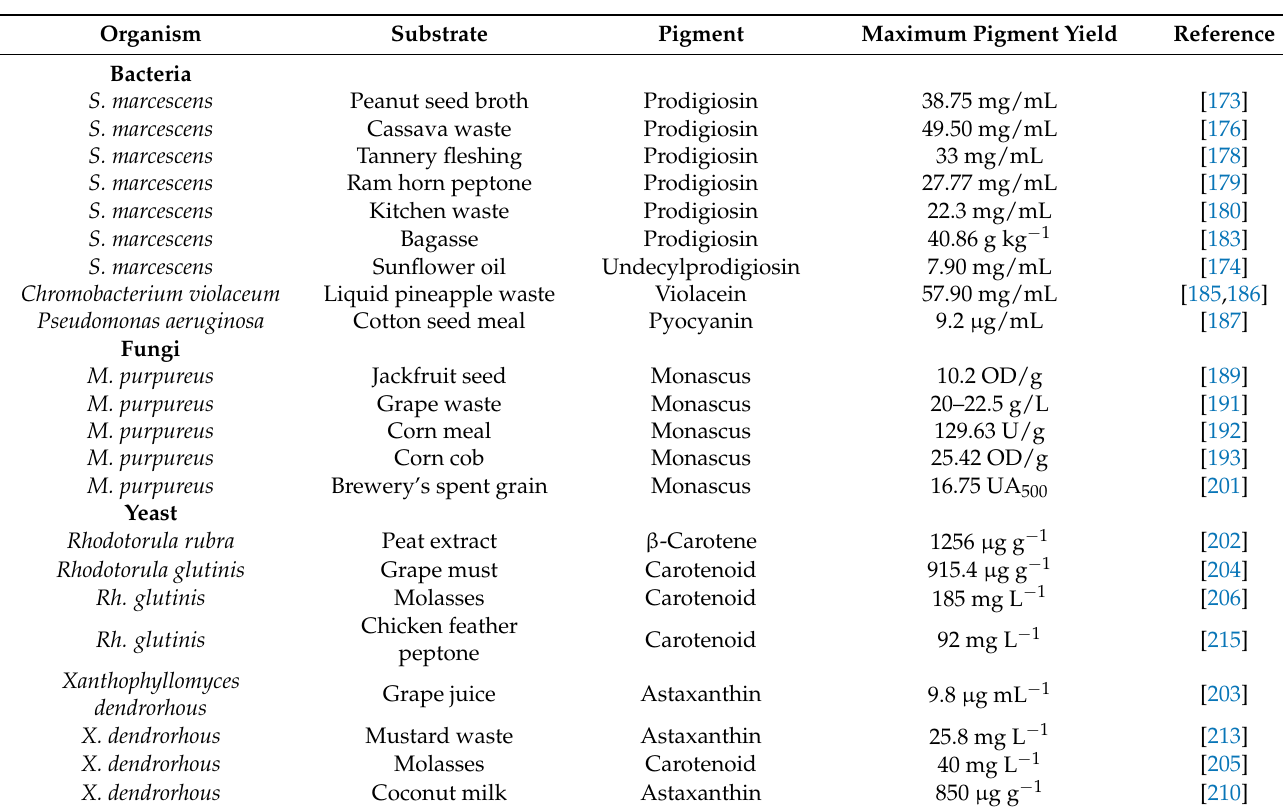
Table 1. Substrates promoting high pigment yield from various microbes are alone detailed herein for further biotechnologi- cal